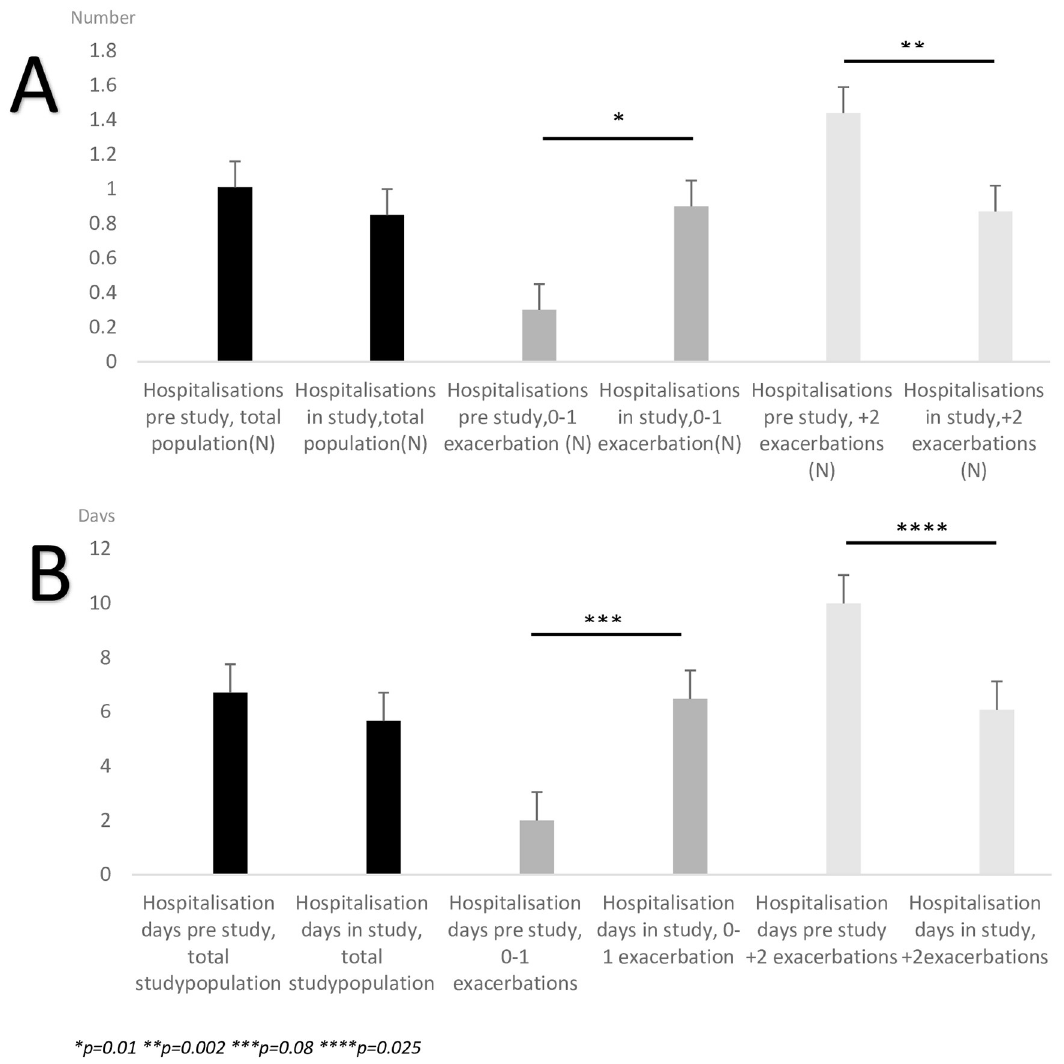
Fig 3. Number of hospitalizations (plate A) and days of hospitalization (plate B) for the total study population and patients with 0–1 exacerbation and 2+ exacerbations the pre-study